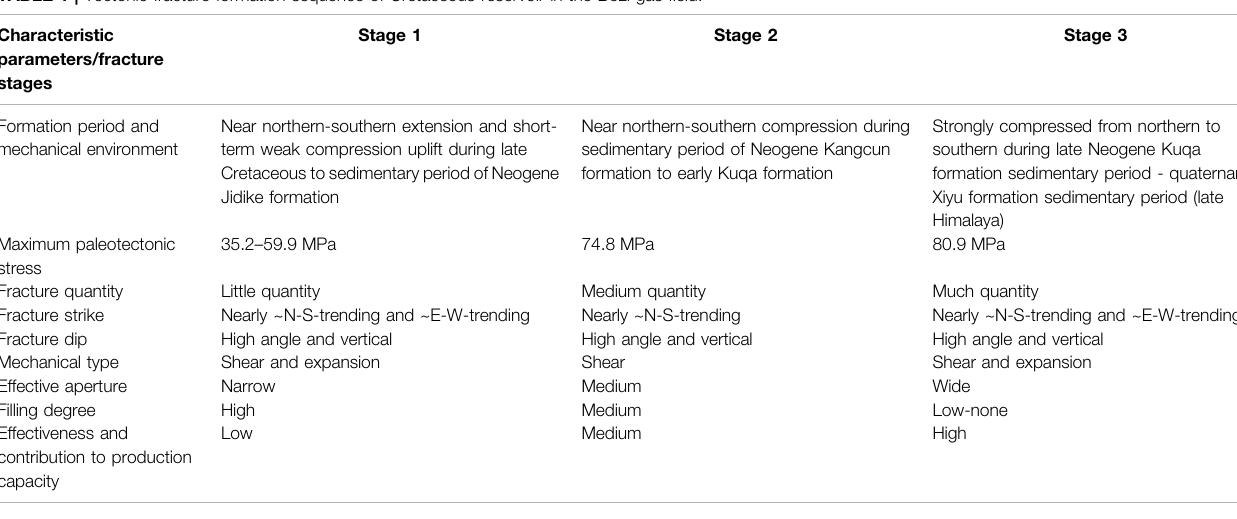
TABLE 1 | Tectonic fracture formation sequence of Cretaceous reservoir in the Bozi gas fi eld.